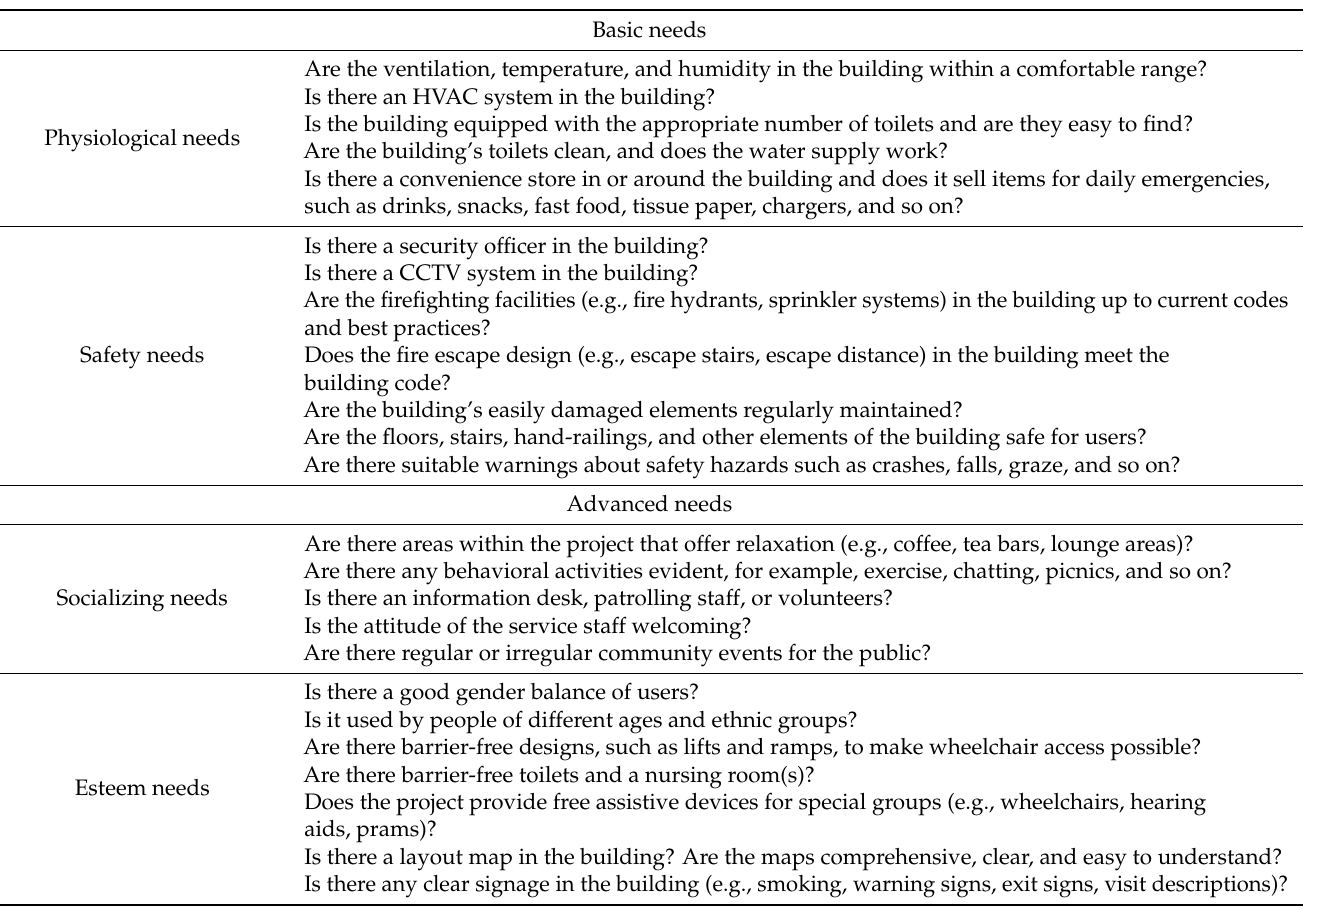
Figure 6. Full assessment framework of basic, advanced, and challenging needs (by author, 2022). Table 1. Questions to consider in the application of the measuring framework (by author, 2022).